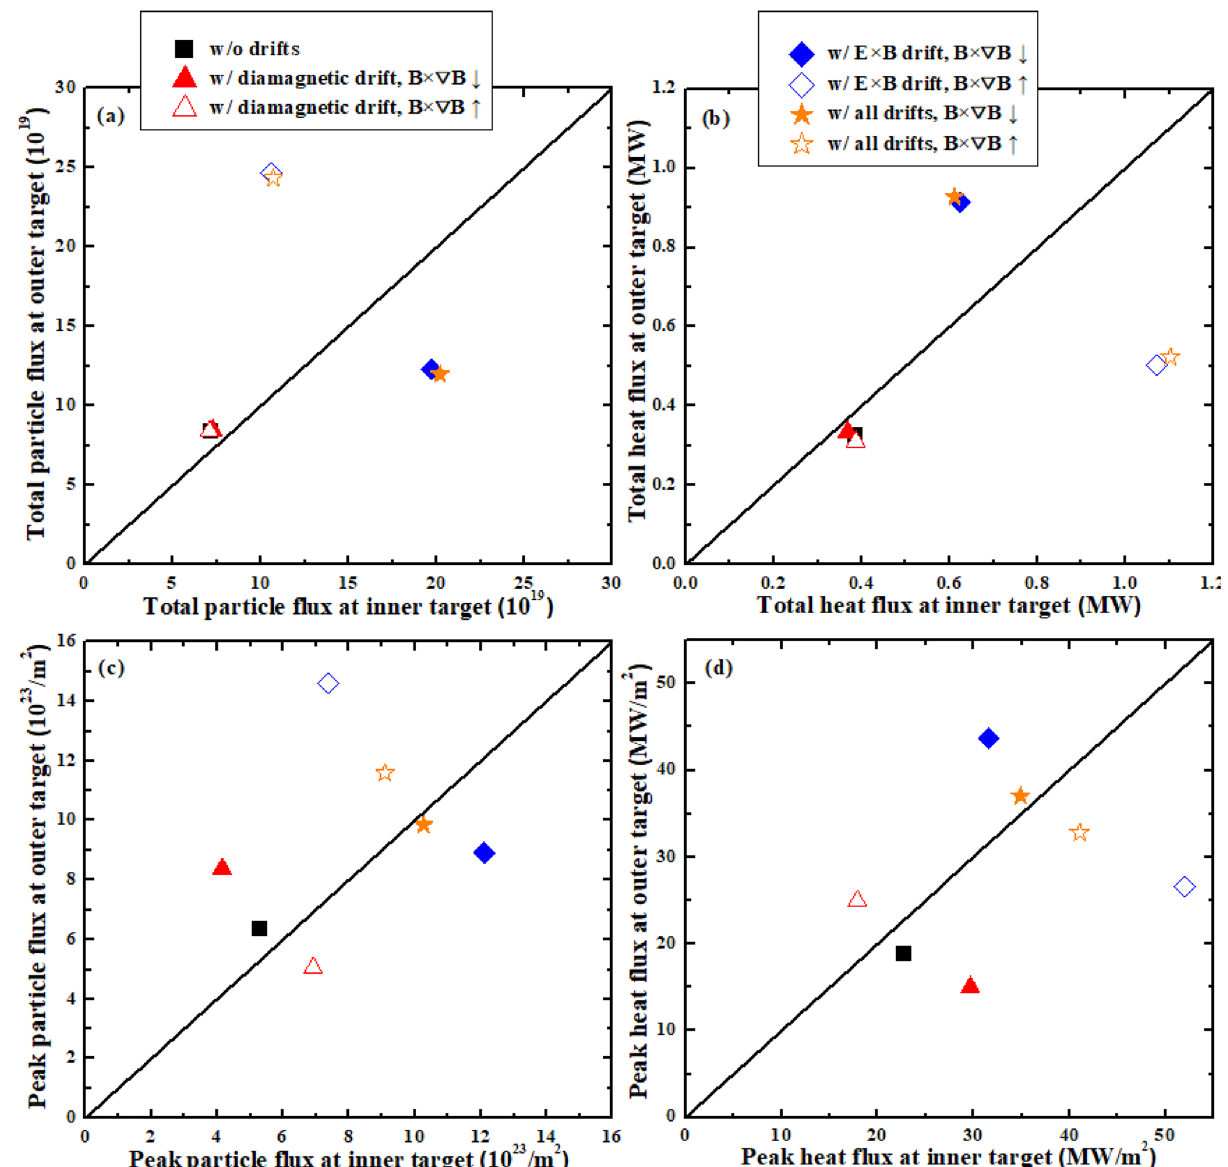
Figure 8. The total and peak particle and heat fluxes at the outer target versus the counterparts at the inner target for the cases without drifts, with only diamagnetic drift, with only E × B drift and with all drifts under normal and reversed toroidal magnetic